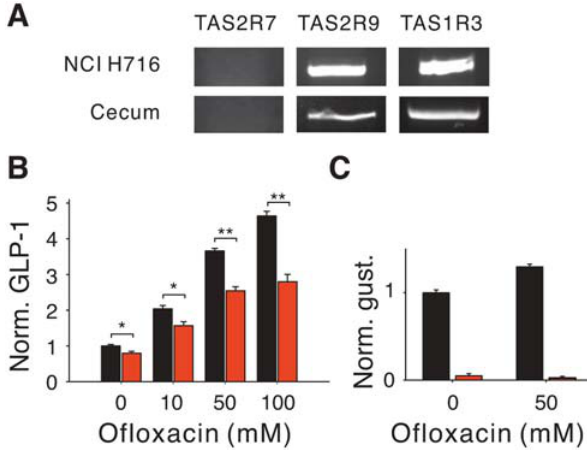
Figure 3. TAS2R9 in enteroendocrine cells. (A) PCR amplicons for TAS2R9 or TAS1R3 from NCI-H716 and human cecum cDNA. The size of the TAS1R3 amplicon (434 bp) indicates no genomic DNA contamina- tion (the genomic product would be 693 bp). TAS2R7 was not amplified from either cDNA pool. (B) GLP-1 secretion from NCI H716 cells in response to ofloxacin stimulation, normalized to the buffer only control, in the absence (black) or presence (red) of an a -gustducin siRNA. The specificity of the siRNA probe for a -gustducin in these cells was previously reported [15]. Repeated measures ANOVA showed signifi- cant effects of concentration ( P , 1 6 10 2 9 ), siRNA treatment ( P =1.4 6 10 2 5 ) and siRNA treatment X concentration ( P =9 6 10 2 5 ). Posthoc t -tests: * P , 0.05; ** P , 0.001. (C) Levels of a -gustducin message in NCI H716 cells measured by quantitative real-time PCR in the absence (black) or presence (red) of the a -gustducin siRNA and normalized for a -gustducin levels in the absence of stimulus and siRNA. Error bars: standard